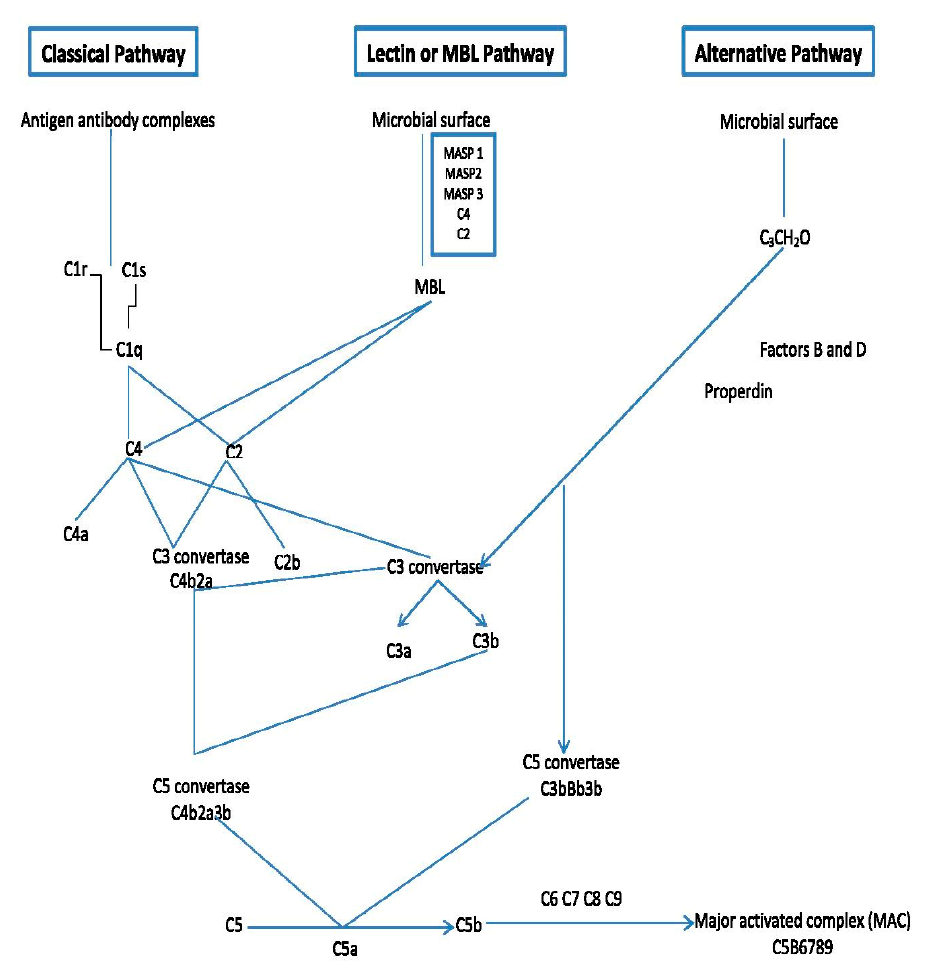
Figure 3. Outline of the major components and mode of action of the complement system.